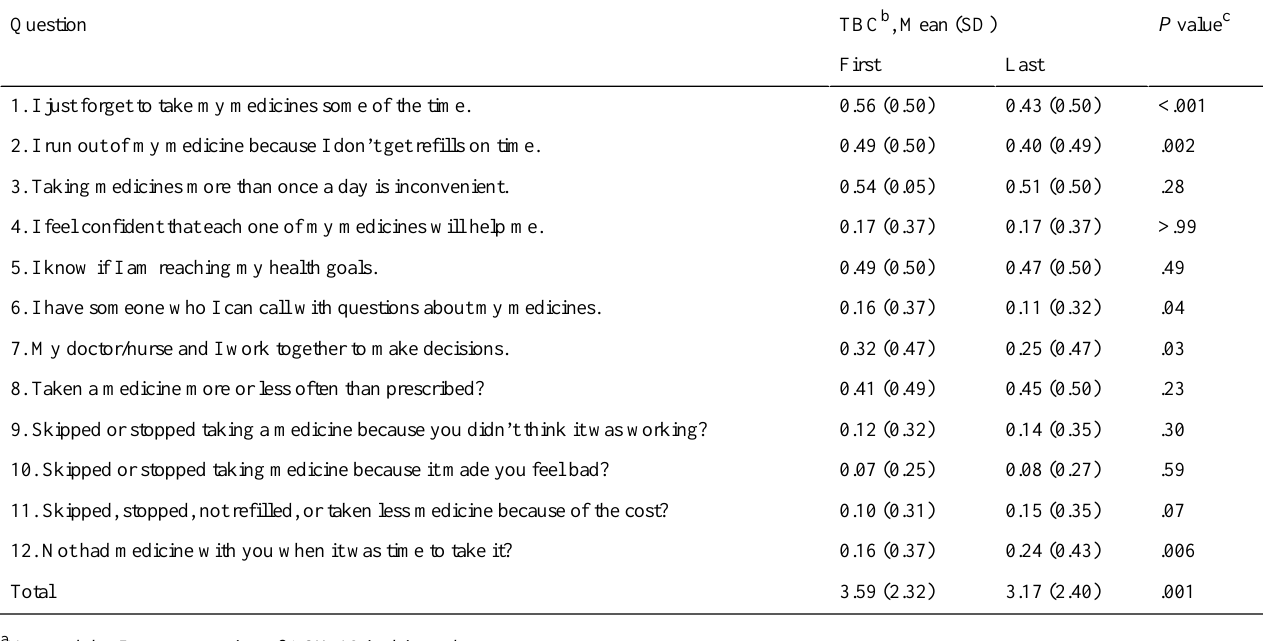
Table 5. A summary of the ASK-12 questionnaire (N=306).